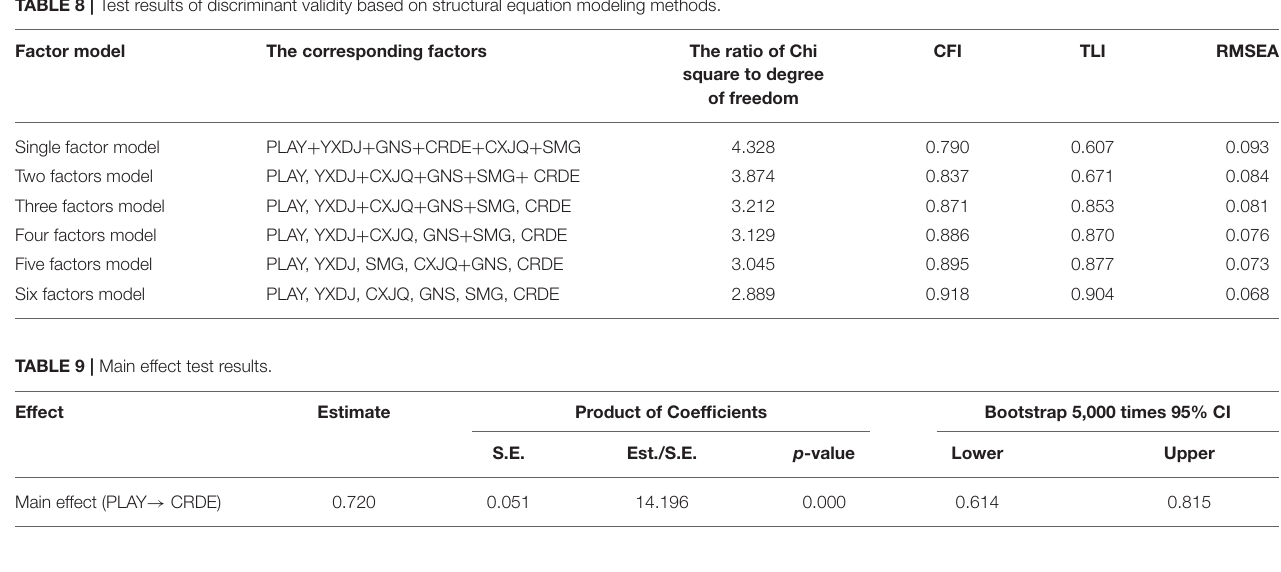
TABLE 8 | Test results of discriminant validity based on structural equation modeling methods.